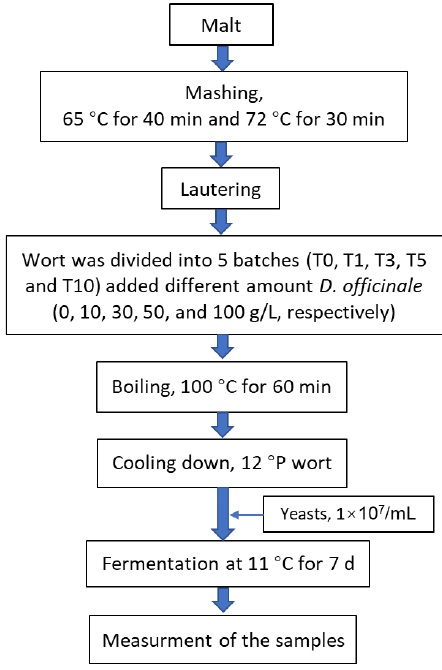
Figure 1. Flowchart of the brewing process.